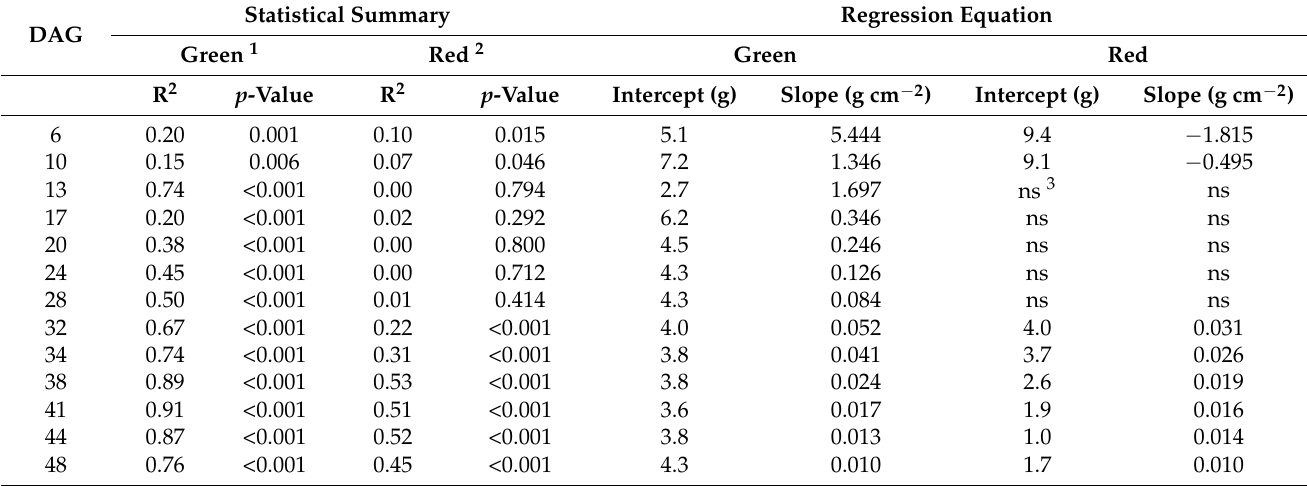
Table 2. Summary of the correlation between shoot dry weight at harvest and the projected canopy size (PCS) at different days after germination (DAG). Regression analyses were conducted separately for cultivars with green and red leaves. All significant correlations from green cultivars were positive correlations, but red cultivars had both positive and negative correlations between PCS and dry weight. Significant regression for green and red cultivars are graphed in Figure S4 and Figure S5,